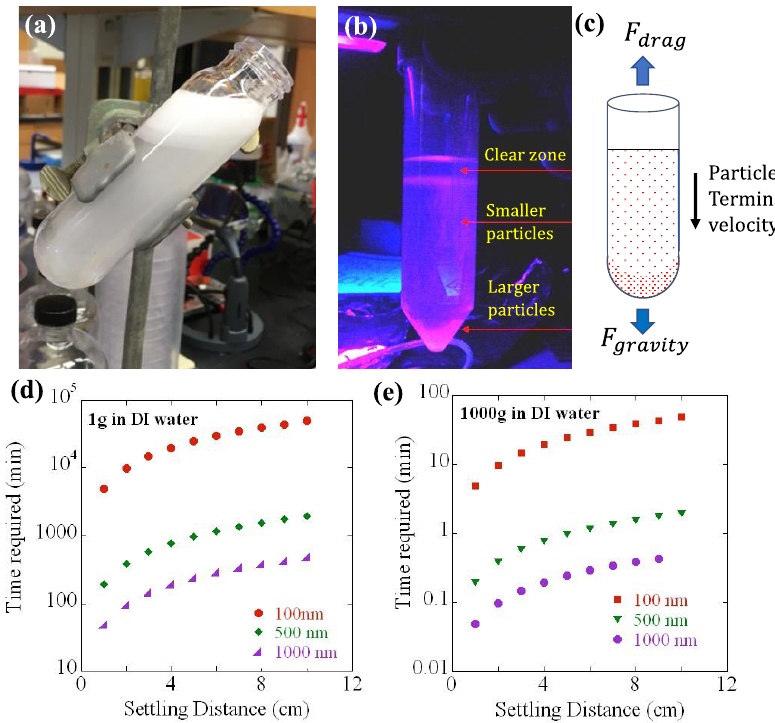
Figure 1. Gravitational/centrifugal separation of nano/submicron-sized particles from commercial several micron-sized phosphors. ( a ) Gd 2 O 2 S:Eu pristine particles being suspended in deionized water. ( b ) The 2.5 micron-sized Gd 2 O 2 S:Eu particle layers suspended in sucrose fluoresces under UV exposure exhibiting a clear gradient in size due to gravitational force pulling the heavier particles down to the bottom of the tube. ( c ) A schematic of the two forces acting on the suspended particles, viz., the gravitational force ( F gravity ) balanced by the viscous drag ( F drag ). Calculated settling distance vs. time for various particle diameters for sedimentation at ( d ) 1 g and ( e ) 1000 g , respectively [ g = 9.8 ms − 2